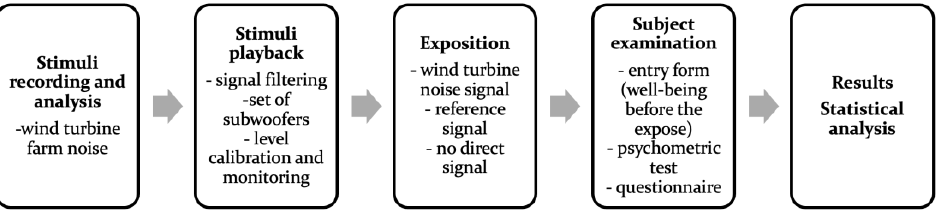
Figure 4. The experiment design.